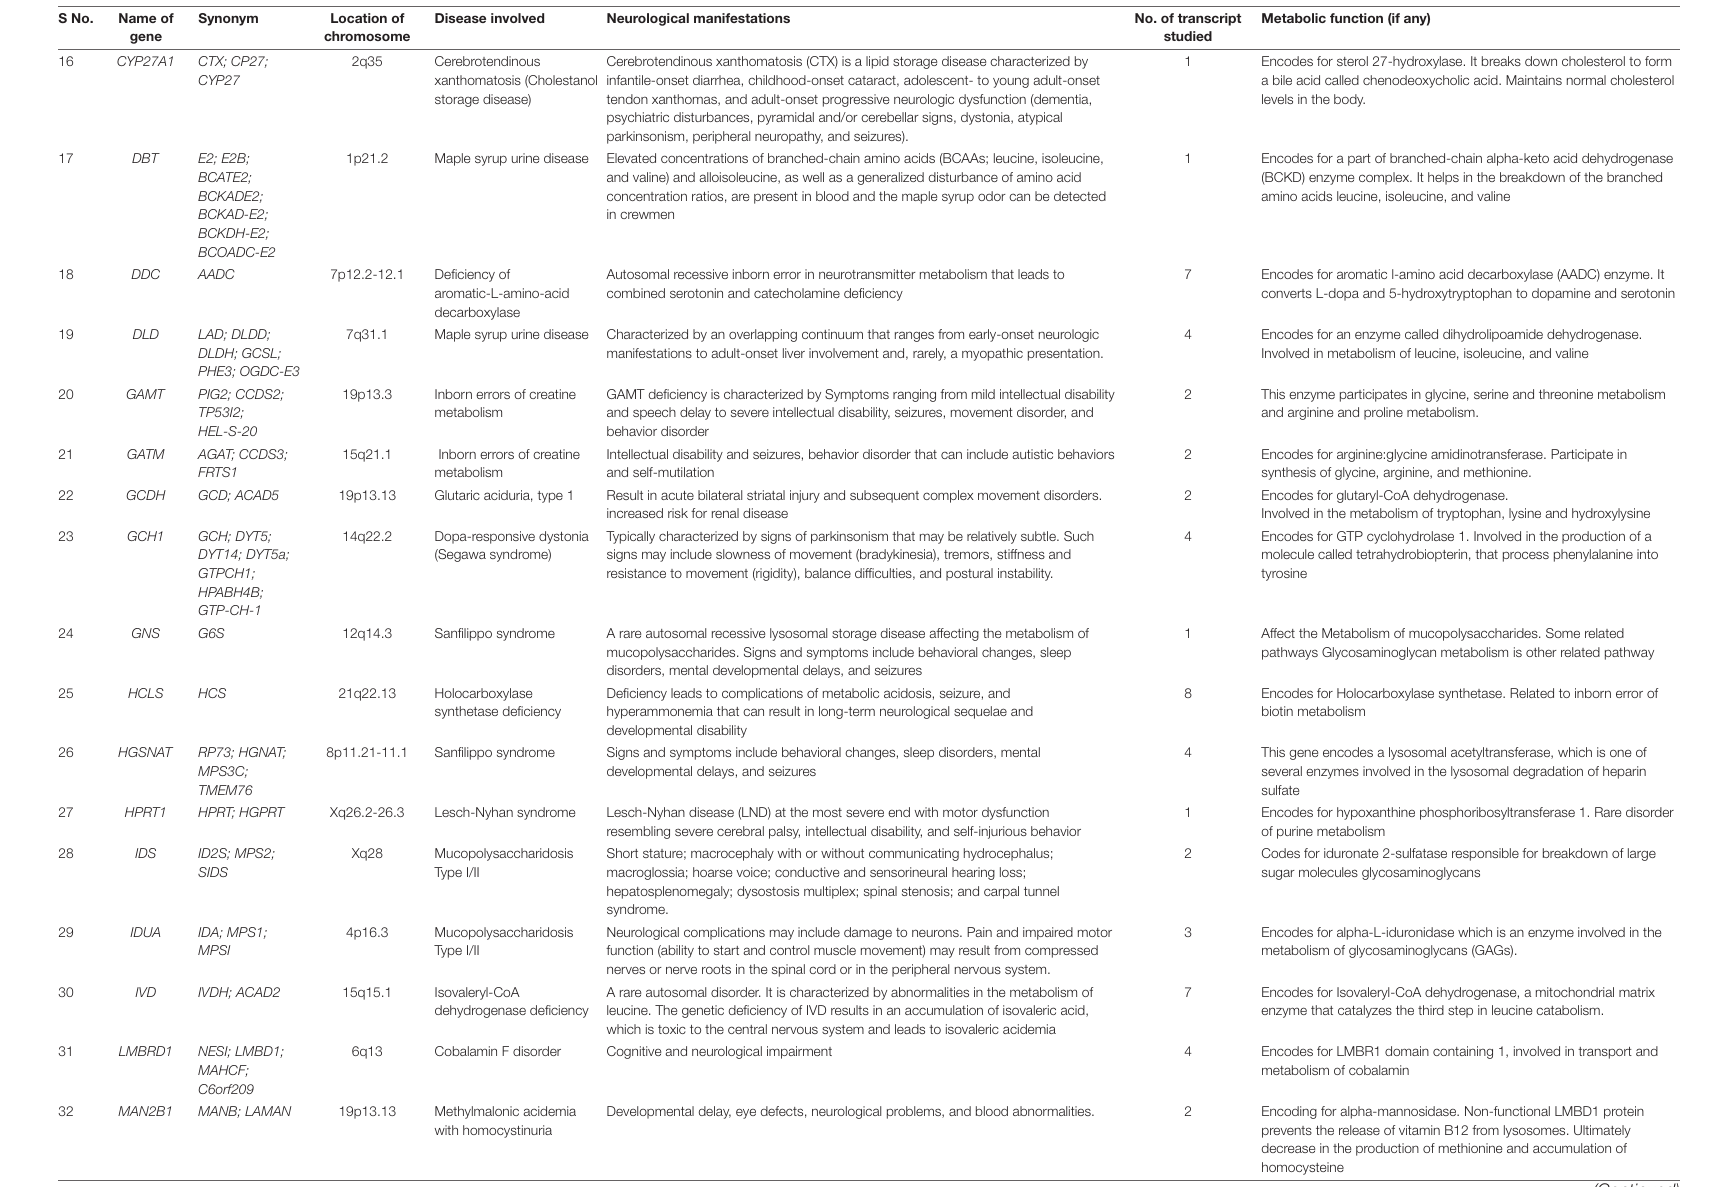
prevents the release of vitamin B12 from lysosomes. Ultimately decrease in the production of methionine and accumulation of